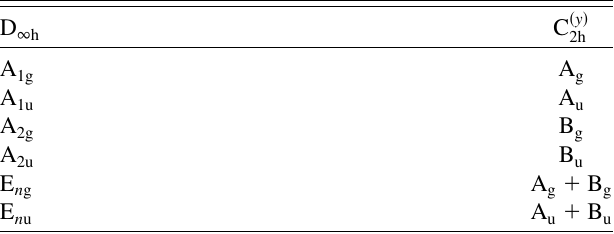
and C (cid:4) y (cid:5) . h 2h